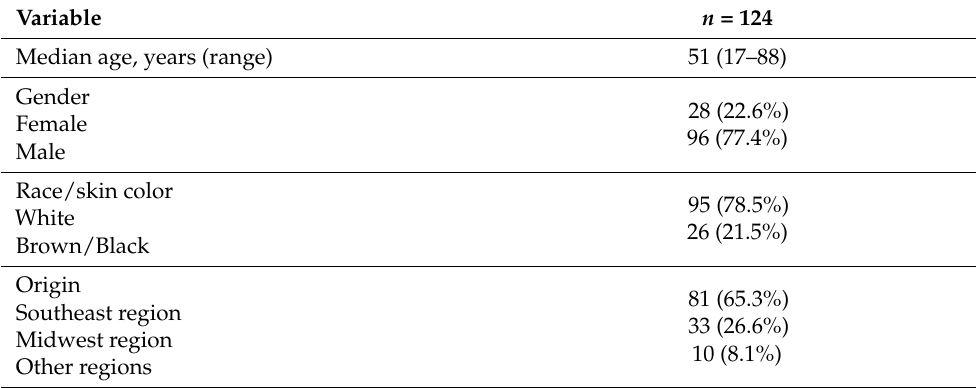
Table 1. Clinical-demographic